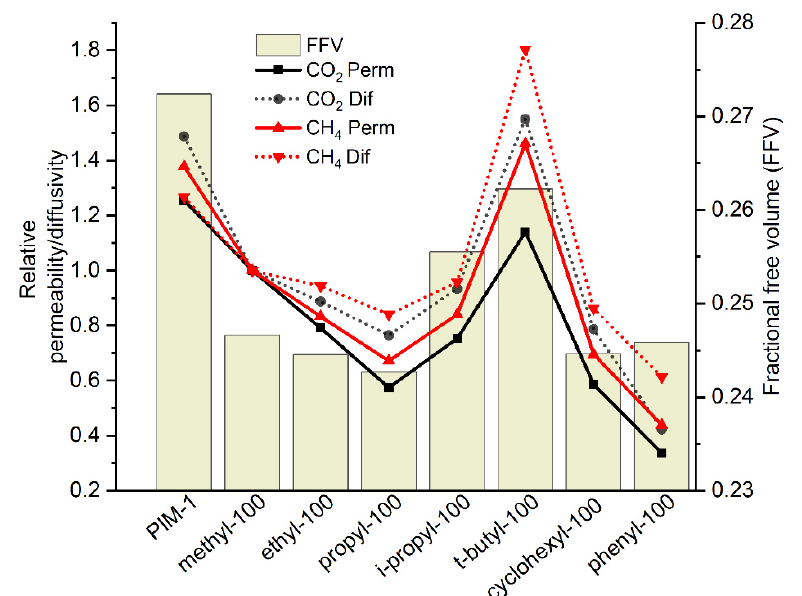
Figure 9. CO 2 and CH 4 relative permeability relative diffusivity and FFV of homopolymers. (Relative permeability or diffusivity: homopolymer gas permeability or diffusivity are normalized to methyl-100 gas permeability or diffusivity.)